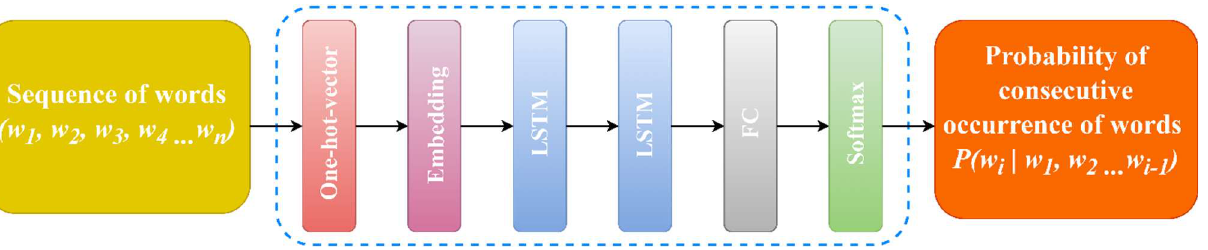
Figure 7. Architecture of neural network language model.